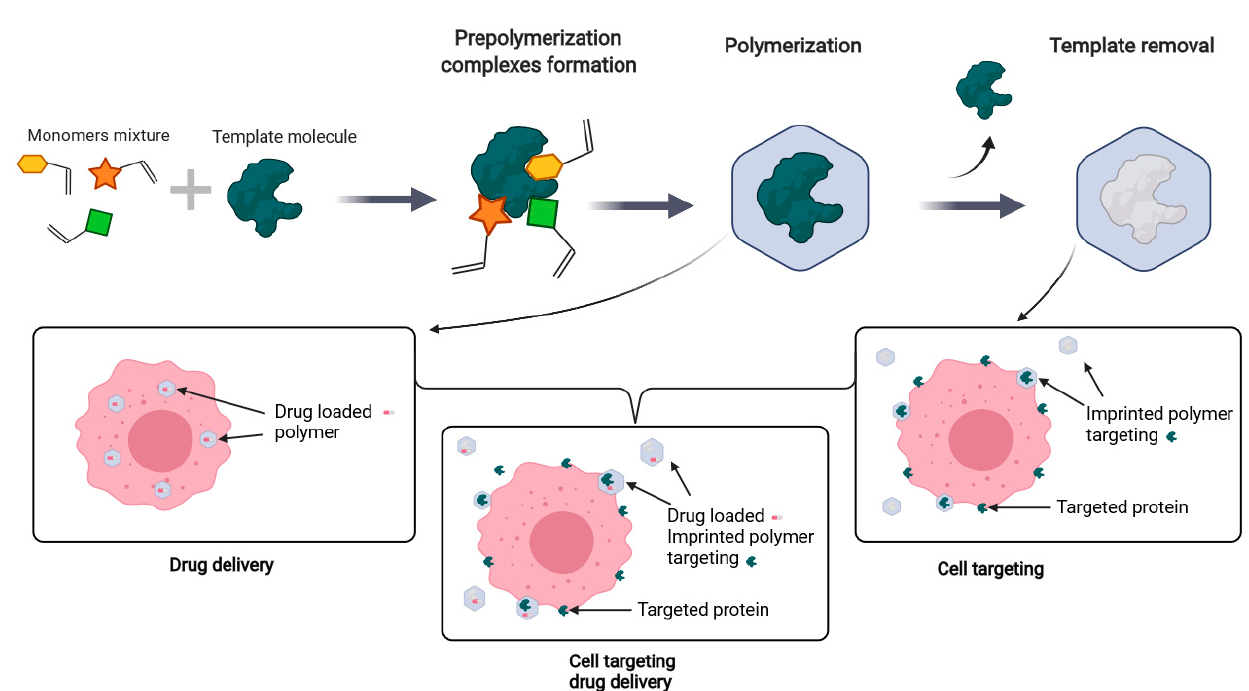
Figure 1. MIPs synthesis principle. The target used as a template is added to a polymer mixture, forming pre-polymerization complexes. After the initiation of the polymerization, the template is embedded inside the polymer matrix and can be removed, forming highly specific cavities. In case of drug delivery applications, the polymer can be reloaded. The imprinting process enables an efficient targeting through a surface protein that can be combined with drug loading of the material. Created with BioRender.com. the 3 April